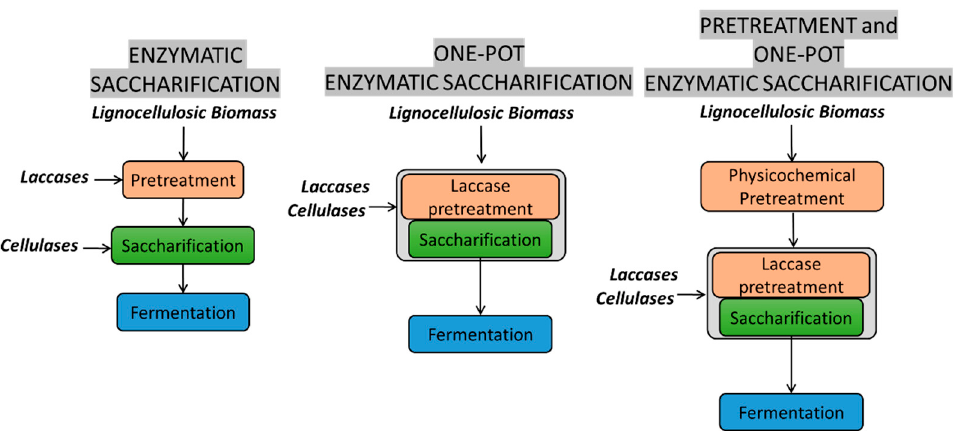
Figure 5. Block diagrams for alternative pretreatment/hydrolysis processes based on the use of laccase for delignification.